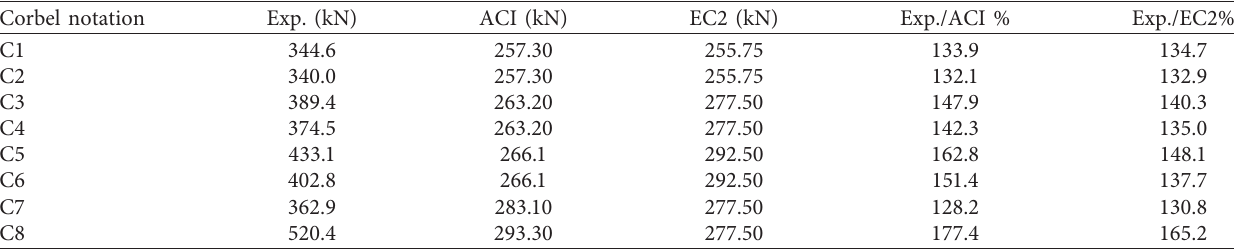
Table 9: Experimental and theoretical ultimate loads.